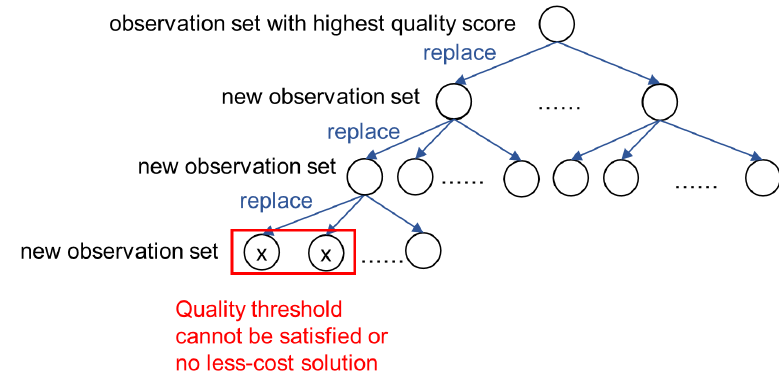
Figure 4. The main idea of the search and prune method for MQQ